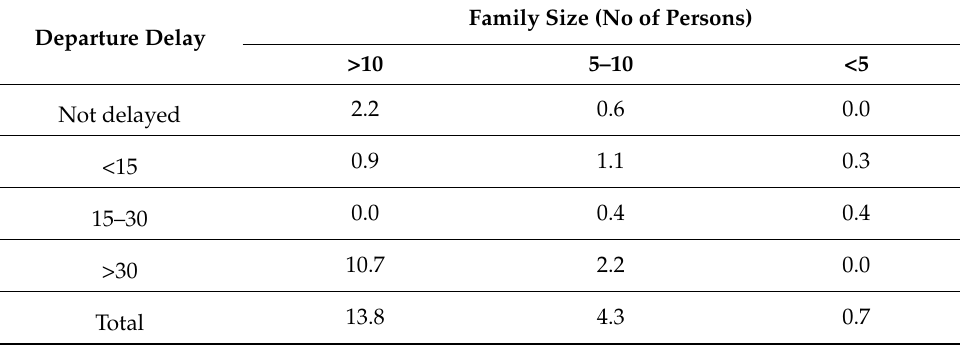
Table 5. Contingency table showing calculated Chi-square